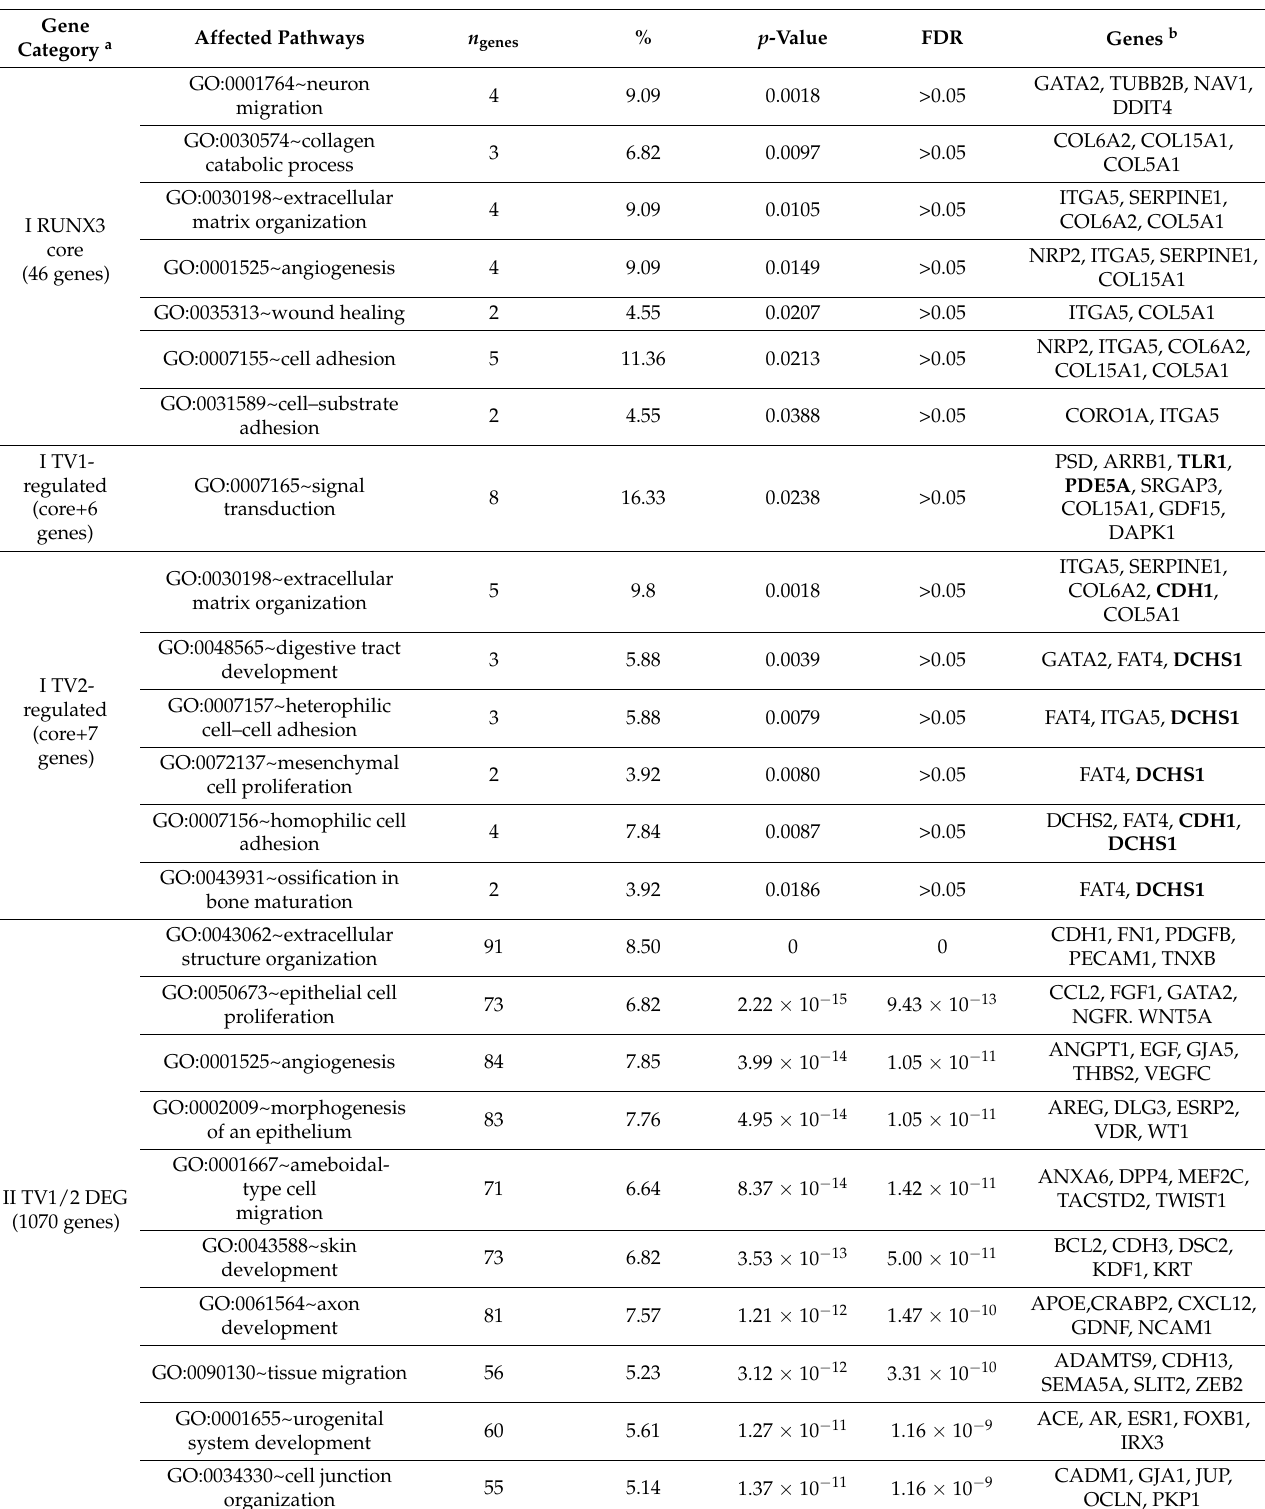
Table 1. Gene ontology-based analyses of epithelial ovarian cancer (EOC)-related RUNX3 core and transcript variant (TV)-specific pathways.